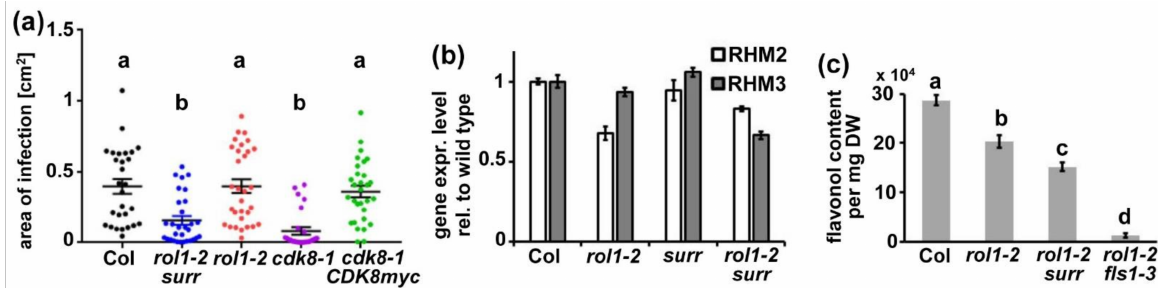
Figure 7. Effect of surr on resistance response, gene expression and flavonols. ( a ) Plants were infected with Botrytis cinerea and the infected leaf area was quantified. As for the cdk8-1 T-DNA insertion allele, surr also induced an increased resistance whereas rol1-2 does not affect susceptibility ty. As control, a cdk8-1 allele transformed with a CDK8cmyc construct was included in the experiment. Different letters above the graphs indicate significant differences (Kruskal-Wallis test). ( b ) For quantitative RT-PCR, 7-day-old seedlings were collected and 300 ng of total RNA was used as starting material. Expression levels of RHM2 and RHM3 in the wild type were set to 1. ( c ) Flavonols were extracted from shoot tissue of 7-day-old seedling and analyzed by High-performance liquid chromatography (HPLC). The area under each peak was used for quantification. Different letters above the graphs indicate significant differences ( T -test, p < 0.01, n = 4). Error bars represent standard